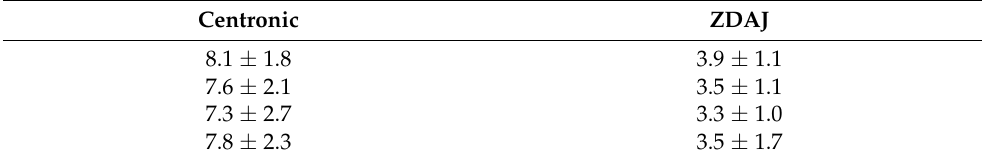
Table 3. The neutron counting rate per hour, for particular Centronic and ZDAJ